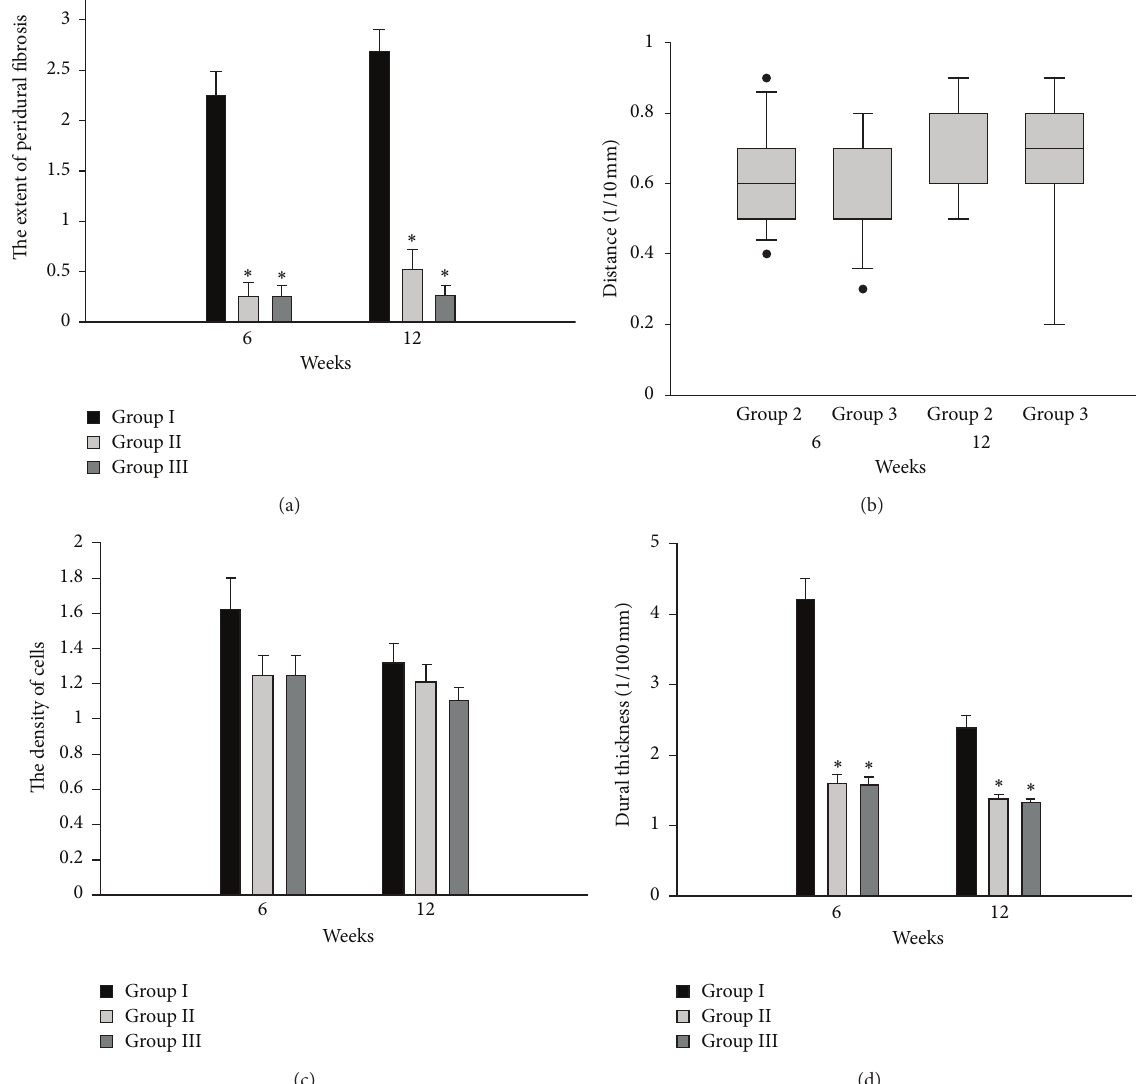
Figure 4: (a) The extents of peridural fibrosis, (b) distances from the dura to the posterior scar tissue in the specimens graded G0, (c) the densities of cells, and (d) dural thickness. Group I: control, group II: HA-CMC, group III: P-ALMC. Groups II and III showed significantly lower extent of peridural fibrosis and lower dural thickness than group I at weeks 6 and 12 ( 𝑃 < 0.001 ). ∗ 𝑃 < 0.05 (Kruskal-Wallis